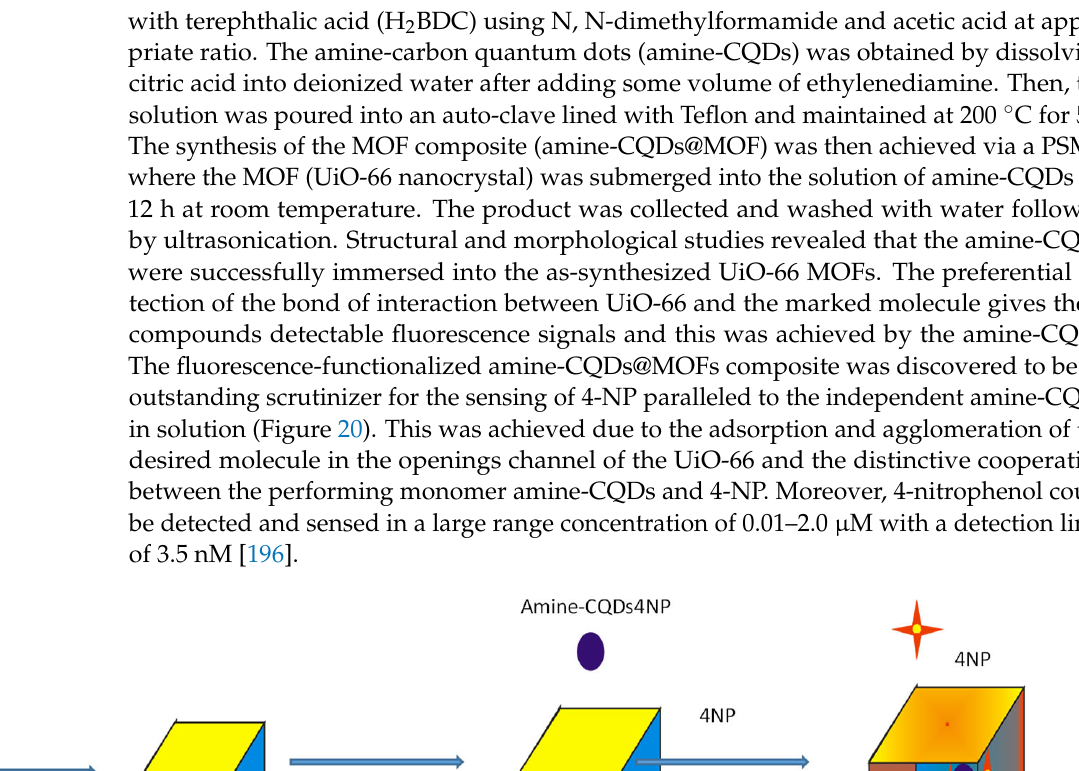
Figure 20. Synthesis of amine-CQDs@MOFs composite and its use as a sensor for 4-nitrophenol.